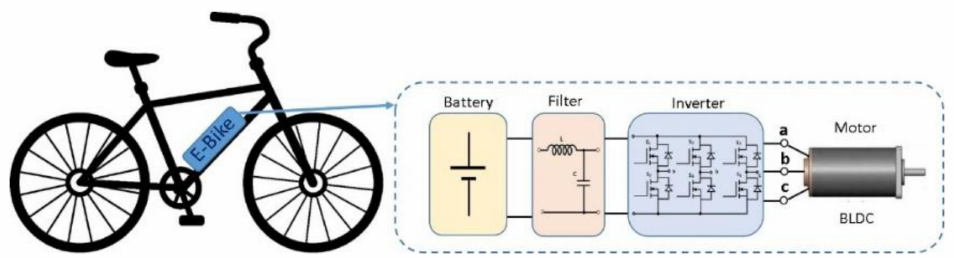
Figure 5. e-bike motor drive system schematic